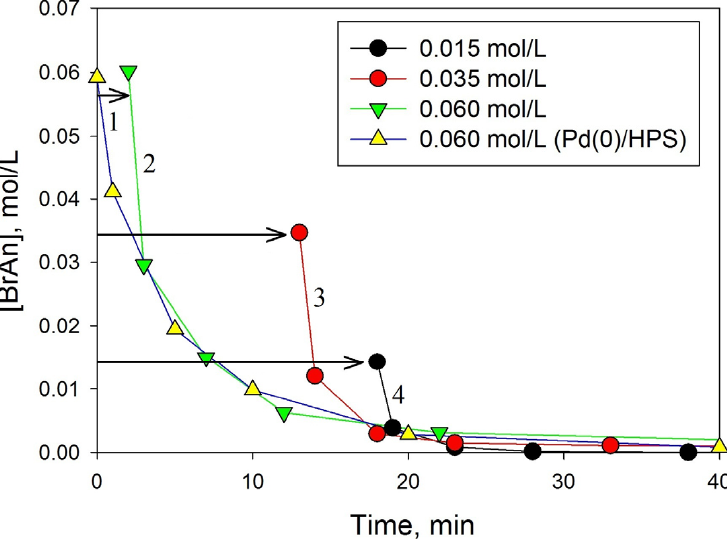
Figure 11. Dependence of the current concentration of BrAn on time in a series of experiments with different initial concentrations of [BrAn] 0 (green triangle—0.060 mol/L, red circle—0.035 mol/L, black circle—0.015 mol/L, curves 2, 3, and 4, respectively) in the presence of Pd(II)/HPS. Kinetic curves are shifted along the time axis by 2, 13 and 18 min, accordingly. Yellow triangles refer to the comparing kinetic curve (1) for the Pd(0)/HPS catalyst.